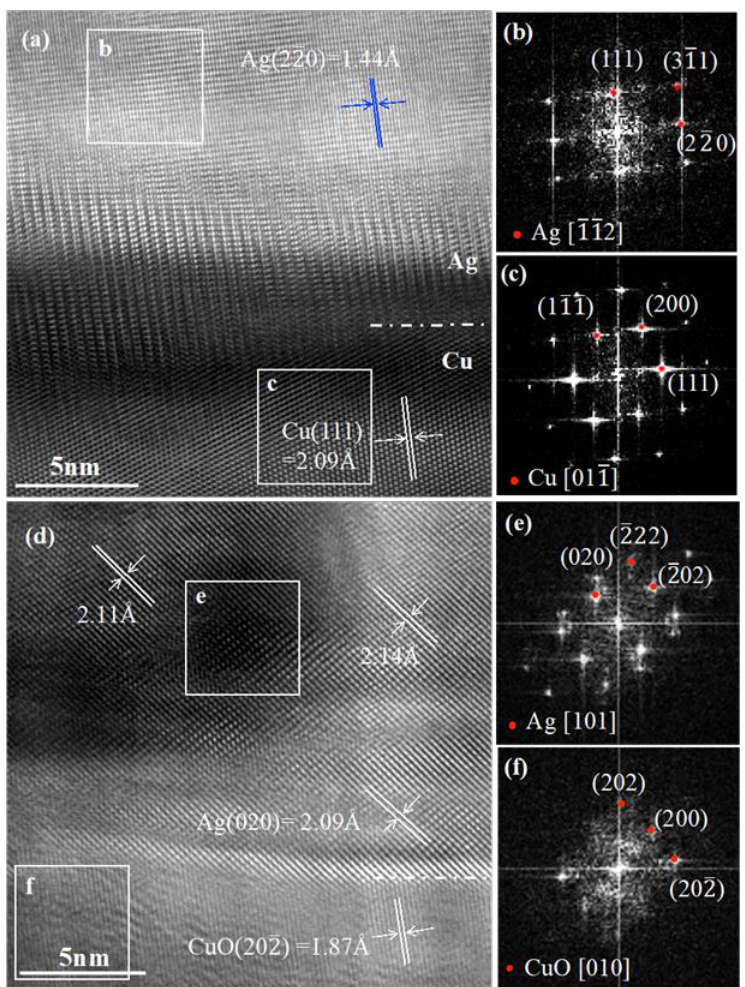
Figure 8. Scanning transmission electron microscope (STEM) image of a local interface between the sintered Ag and the Cu substrate: ( a ) with and ( d ) without formic acid treatment. ( b , c ) are the fast Fourier transform (FFT) images corresponding to the squared areas in ( a ), and ( e , f ) are the FFT images corresponding to the squared areas in ( d ). The bonding time is 30 min.